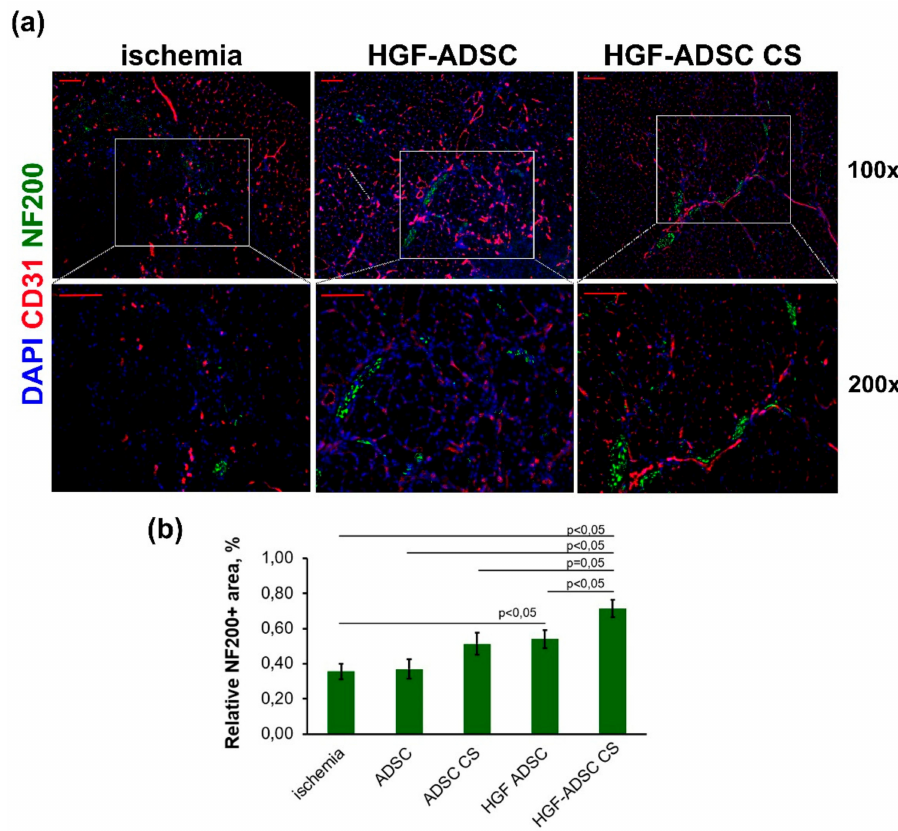
Figure 5. Neuronal innervation in ischemic muscle at day 14 after ischemia induction and cell sheets / cells transplantation. ( a ) Representative images of m. tibialis anterior sections from ischemia, ADSC, ADSC CS, HGF-ADSC and HGF-ADSC CS groups stained against murine NF200, CD31 and DAPI (100 × and 200 × magnification); ( b ) graphical presentation of neuronal innervation assessment using relative area of NF200 + structures per FOV. Data are presented as mean ± SEM (Mann–Whitney U-test). Scale bar = 50 µ m. HGF = hepatocyte growth factor, CS = cell sheet, ADSC = adipose-derived stromal cells. NF200 = Neurofilament 200, DAPI = 4 (cid:48) ,6-diamidino-2-phenylindole, FOV = field of